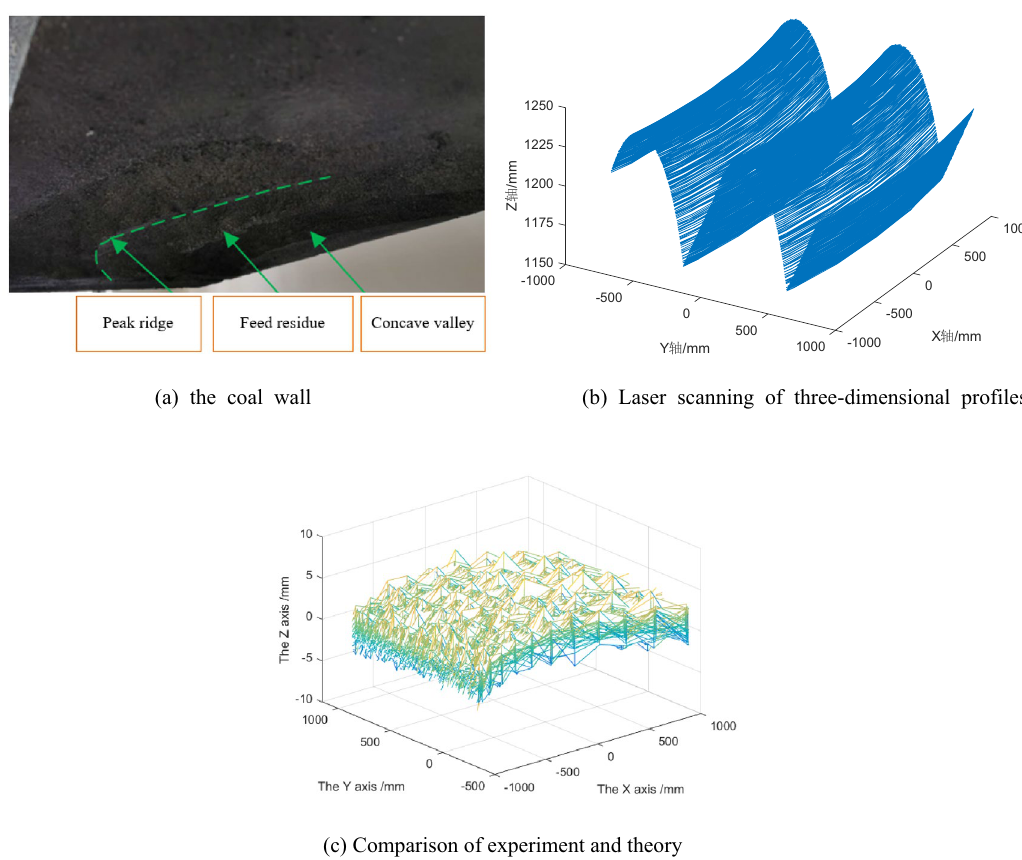
Figure 9. Experimental results of cutting false coal wall.